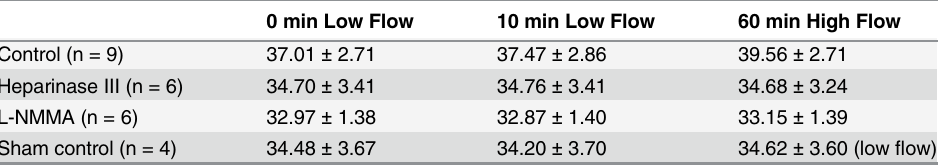
Table 1. Diameters of post-capillary venules under low (~300 μ m/s) and high (~1000 μ m/s) fl ows.